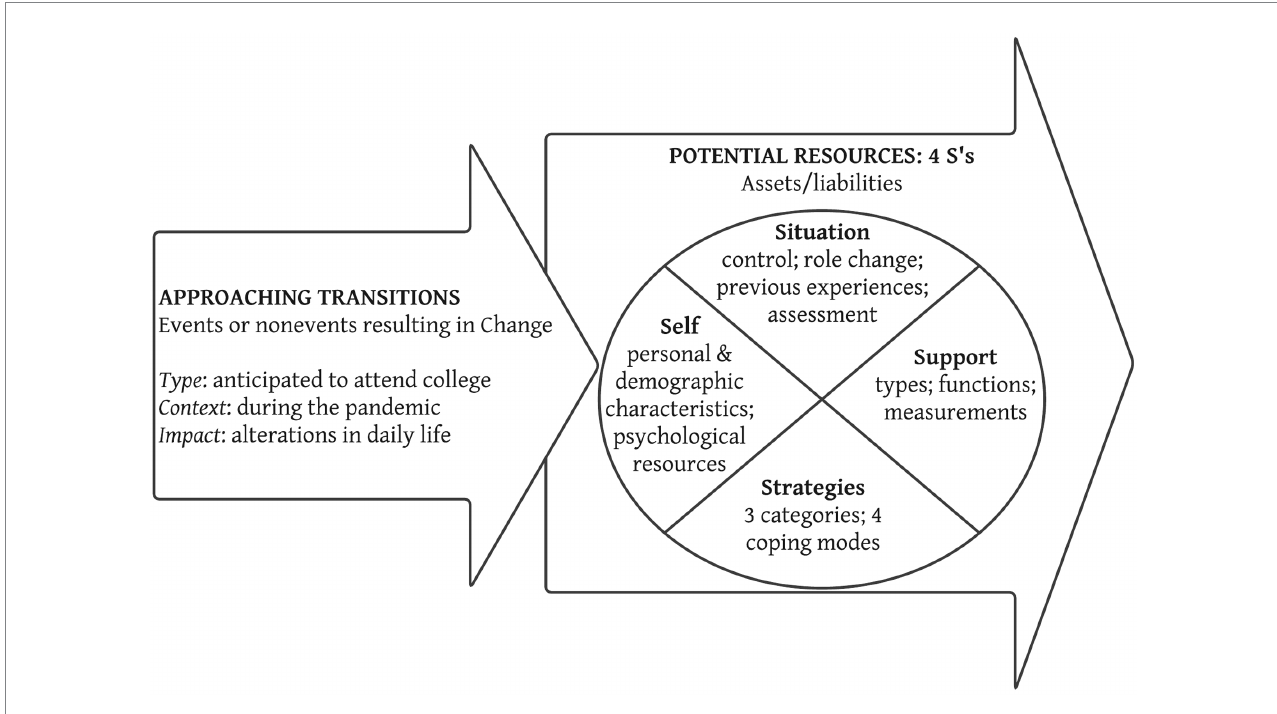
FIGURE 1 The transition process: moving in and moving